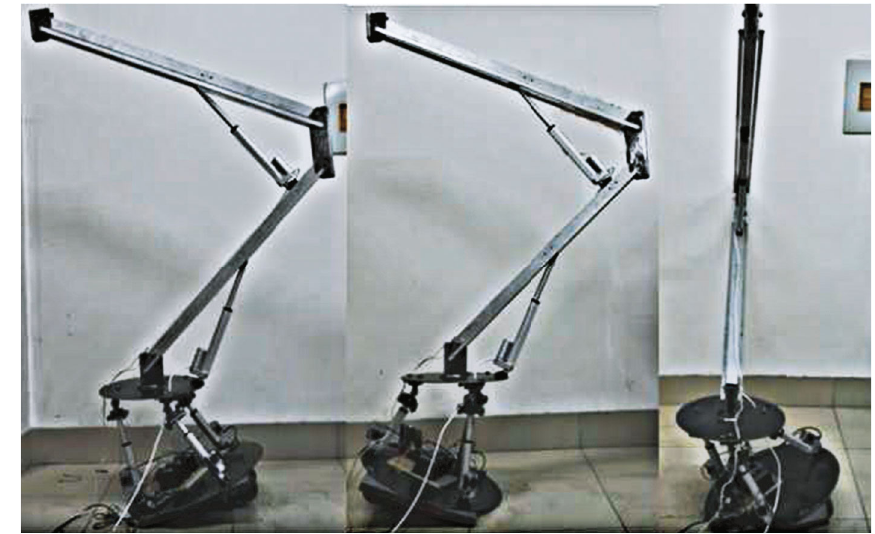
Figure 23: Adjusting platform state diagrams of di ff erent